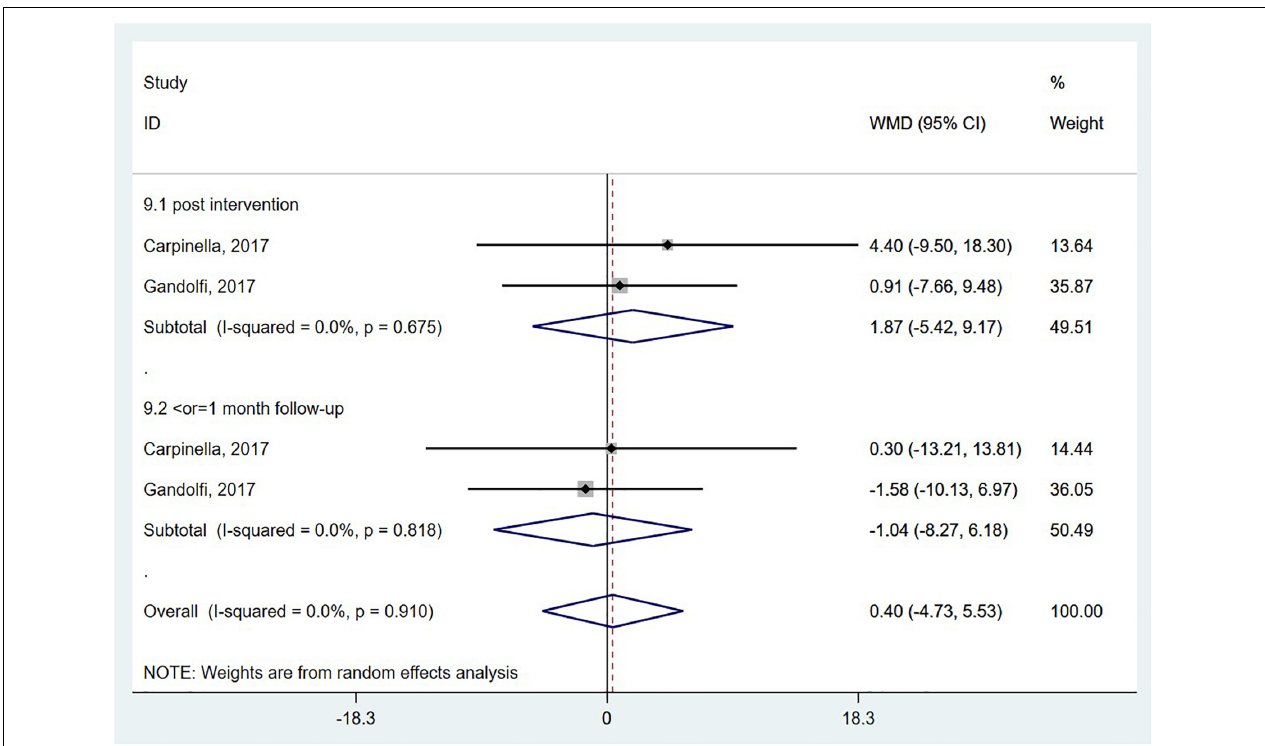
FIGURE 9 | Forest plot of pooled results for activities-specific balance confidence